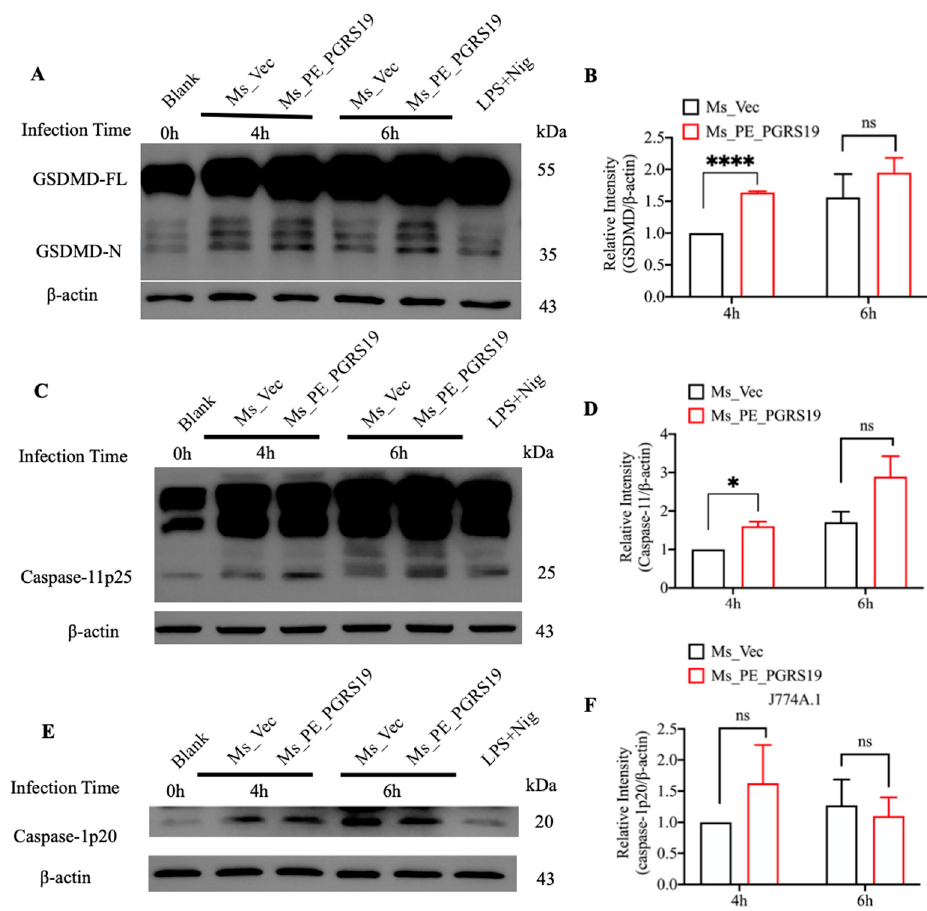
Figure 5. PE_PGRS19 overexpression upregulates the cleavage of GSDMD and caspase-11 in J774A.1 cells. Whole-cell lysate proteins were detected to measure the cleavage of ( A ) GSDMD and ( B ) relative intensity at 0, 4 and 6 h post-infection with Ms_PE_PGRS19 and Ms_Vec in J774A.1 cells. The cleavage of ( C ) caspase-11 and ( D ) relative intensity was measured, as well as ( E ) caspase-1 and ( F ) relative intensity. LPS treatment (4 h) and nigericin stimulation (2 h) were used as positive controls to induce pyroptosis. Multiple t -tests were performed using with the Holm–Šídák method. ns p > 0.05, * p < 0.05, **** p < 0.0001. Data are presented as x ̄ ± SEM of three independent experiments.